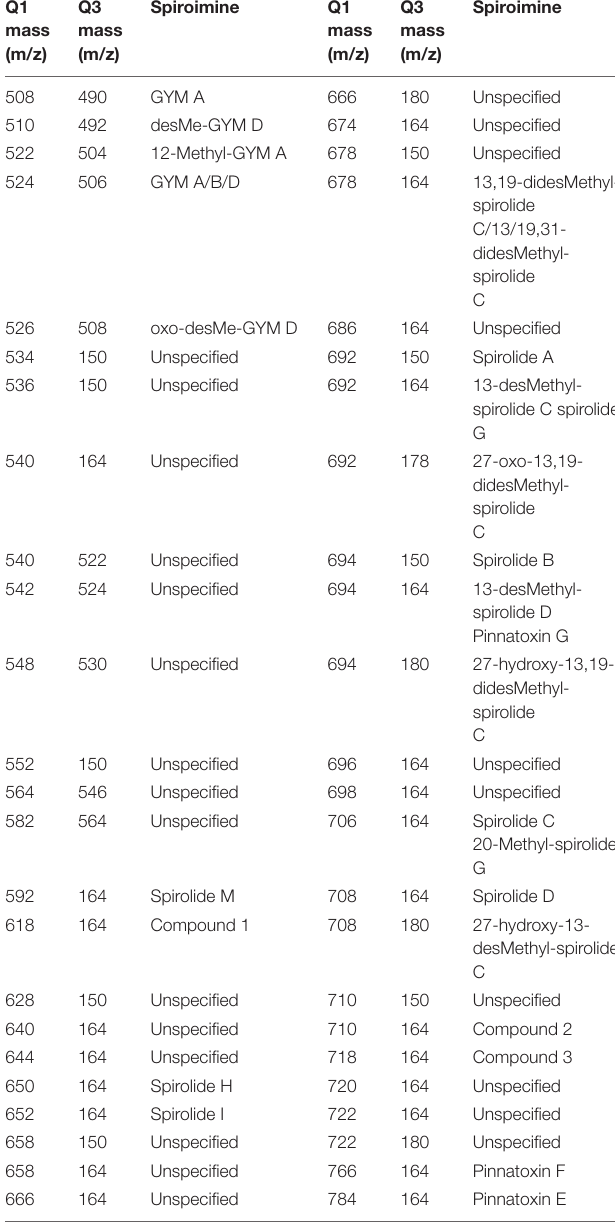
TABLE 2 | Mass transitions (Q1 and Q3 masses) used for the screening and quantification of spiroimines and corresponding spiroimines. Q1